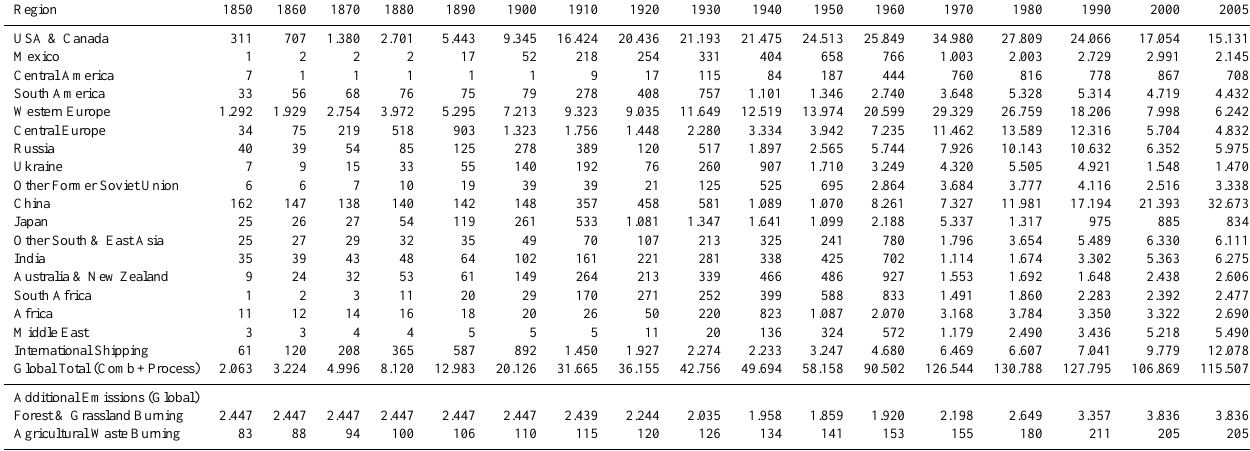
Table 2. Total emissions estimates by decade (for the indicated year) and region (GgSO 2 ) , with global emissions shown from sectors not included in the country-level estimates (open biomass burning from forest, grassland, and agricultural waste burning on fields, see text).